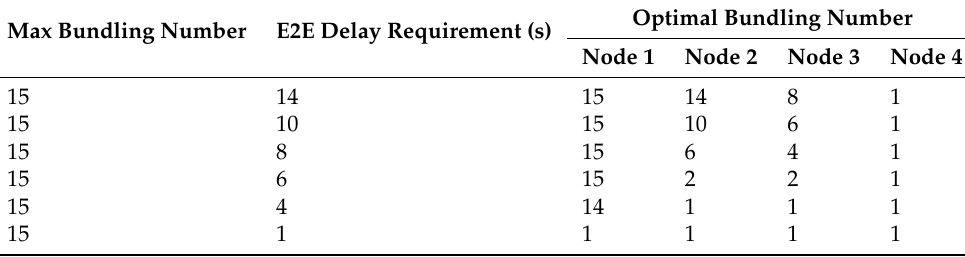
Table 2. Optimal bundling number under different end-to-end (E2E) delay requirements during the dynamic experiment as shown in Figure